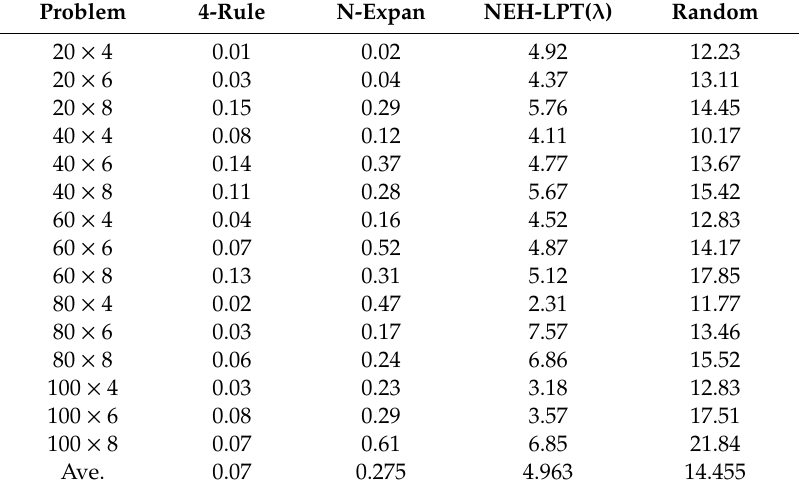
Table 1. Comparison results for the RPI values of the four simulation policies.